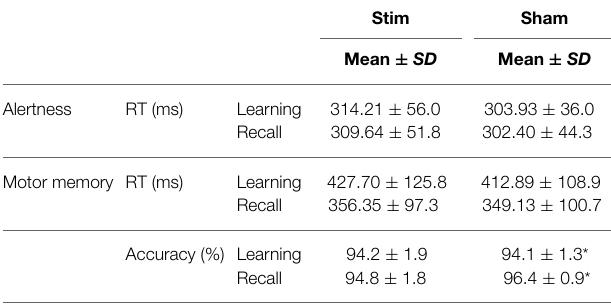
TABLE 2 | Results of the go/no-go task. STIM SHAM p -values